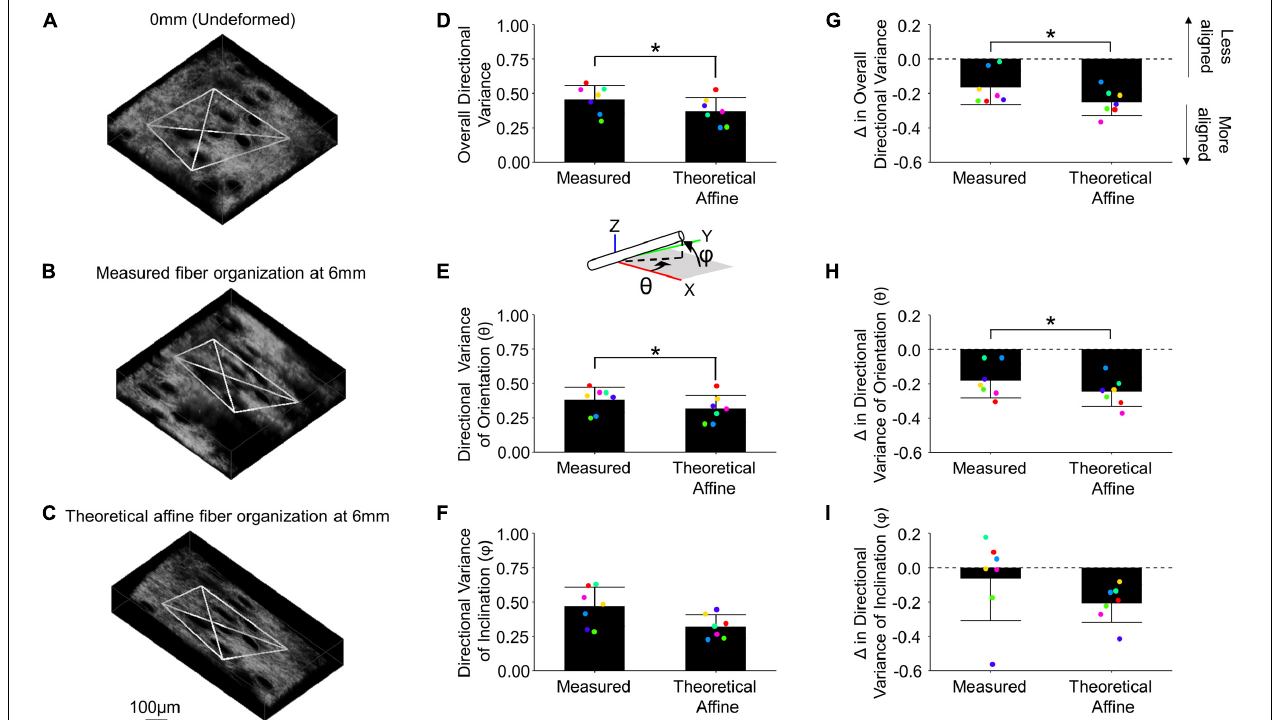
FIGURE 6 | Collagen fiber kinematics are not affine with the local skin deformation. Micro-scale image volumes were compared among the undeformed configuration (A) , actual tissue response at peak strain (B) and the theoretical affine transformation (C) based on the measured deformation gradient. The white tetrahedron in panels (A–C) indicates the position of 3D image features that were tracked during deformation (scale bar represents 100 µ m). The computed 3D directional variance (D) as well as the measured directional variance for individual 3D orientation and inclination components [ θ and ϕ , panels (E,F) , respectively] were found to be higher than the theoretical affine transformation. Similarly, the change in overall directional variance (G) and the 3D orientation and inclination components (H,I) indicate the measured fiber re-alignment in the direction of loading is less than the theoretical affine response. Points are colored to indicate paired comparisons among groups. *represents p <